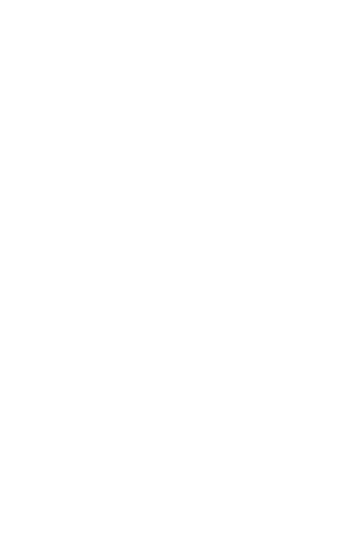
Fig 10. Evolution of bone defect filling with new bone tissue in vivo and in silico . Percentage of the defect volume filled with bone tissue, for different doses of BMP-2.